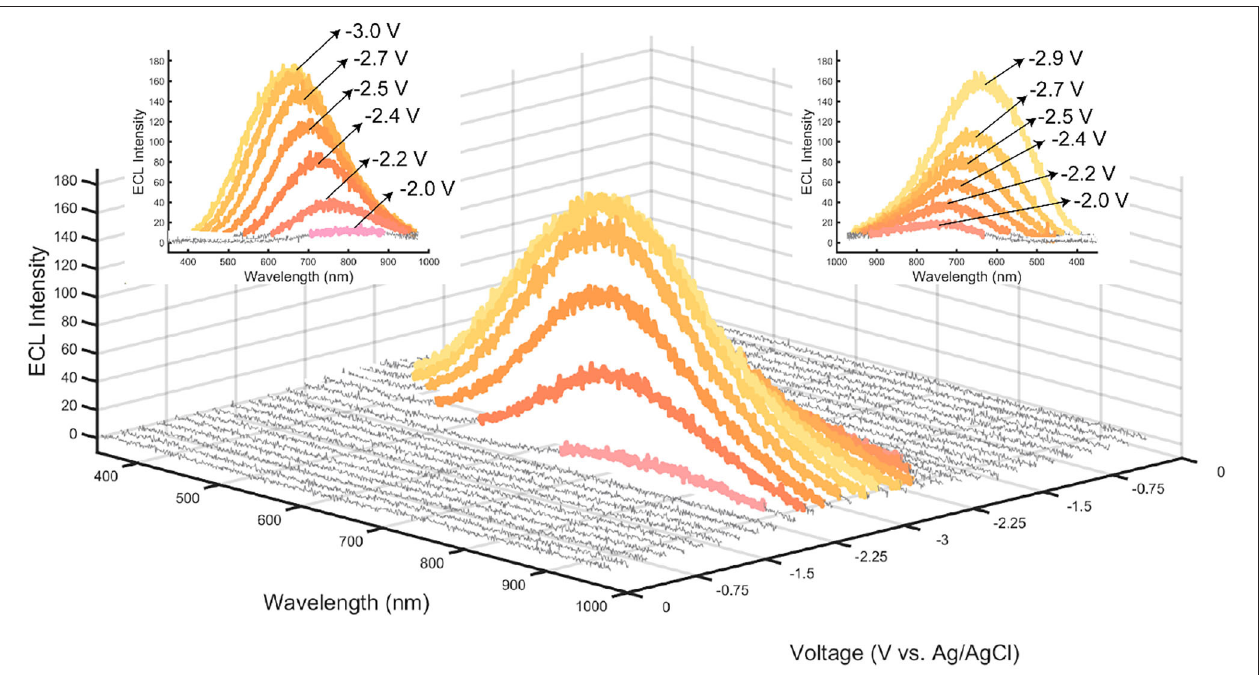
FIGURE 5 | ECL spooling spectra from a film of CQD10 with 50mM K 2 S 2 O 8 taken with an exposure time of 2s, a scan rate of 12.5 mV/s, yielding 120 spectra over a 240s cyclic voltammogram. Color of individual spectra correspond to the RGB coordinates found by converting spectra using CIE coordinates. Spectra that show negligible light are displayed as gray. Insets show the wavelength of light emitted from a. the forward scanning starting at − 2.0V vs. Ag/AgCl and b. the reverse scan starting at − 3.0V vs.